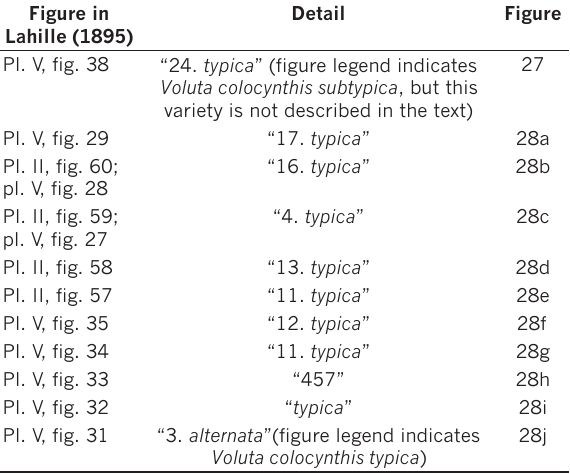
Table 10. Voluta colocynthis typica , specimens figured by La - hille (1895) with the detail of the inscriptions on their shells and figures here.